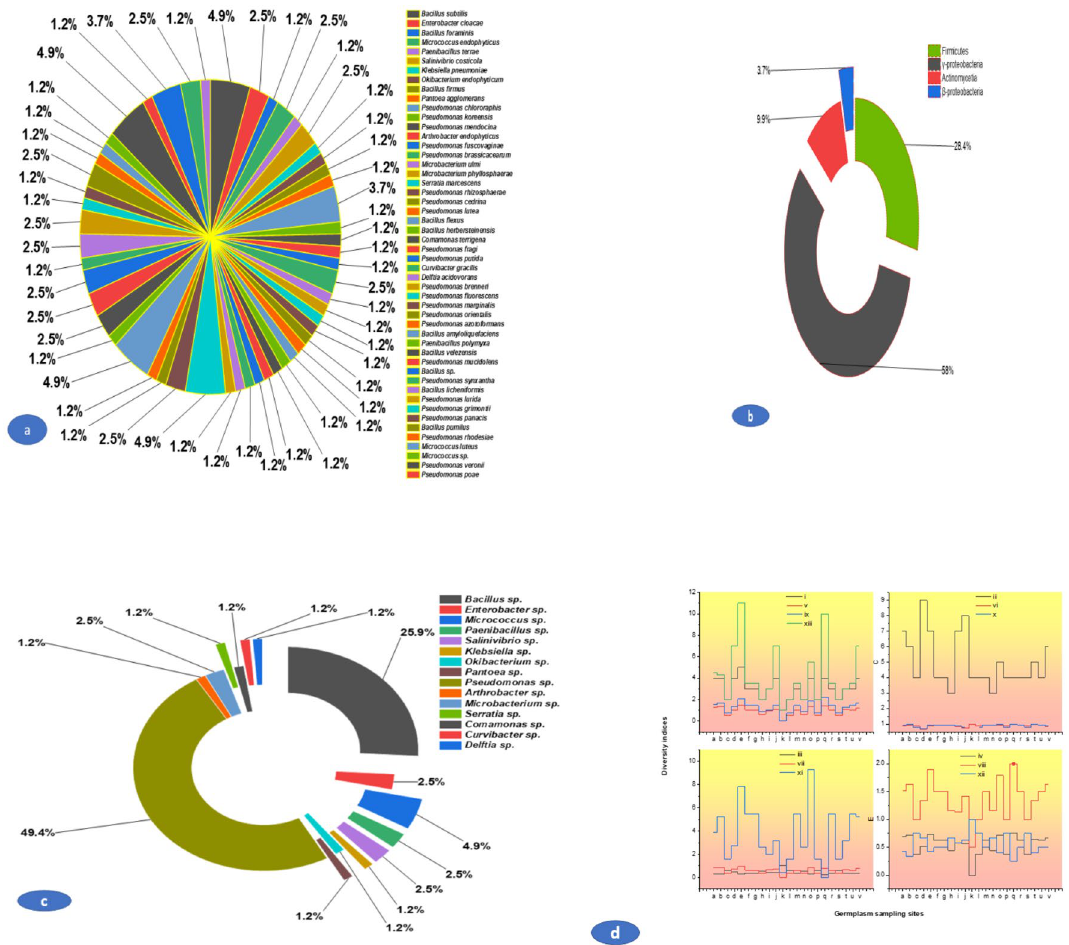
Figure 1. Structure of culturable bacterial endosymbiosiome associated with B. rapa L.; ( a ) Relative proportion of (species level); ( b ) Relative proportion of (genus level); ( c ) Relative proportion of the taxonomic classes; ( d ) Diversity indices of bacterial endosymbiosiome where symbols: (i) Taxa_S; (ii) Individuals; (iii) Dominance_D; (iv) Simpson_1-D; (v) Shannon_H; (v) Evenness_ e^H/S; (vii) Brillouin; (viii) Menhinick Margalef; (ix) Equitability_J; (x); (xi) Fisher_alpha; (xii) Berger-Parker and (xiii) Chao-1 and similarly the letters inside figures represent different sampling sites: (a)Akura; (b) Bona Nambal; (c) Hugam; (d) Hutmara; (e) Panzmulla; (f) Rakh Chandipora; (g) Tujar; (h) Bomai; (i) Brath; (j) Juhama; (k) Kanispora; (l) Fateh Pora; (m) Nowgam; (n) Rawalpora; (o) Rangreth; (p) Khunmoah; (r) Zakura; (s) Gulab Bagh; (t) Ahmad Nagar; (u) Dhara; (v) Tailbal and (w)